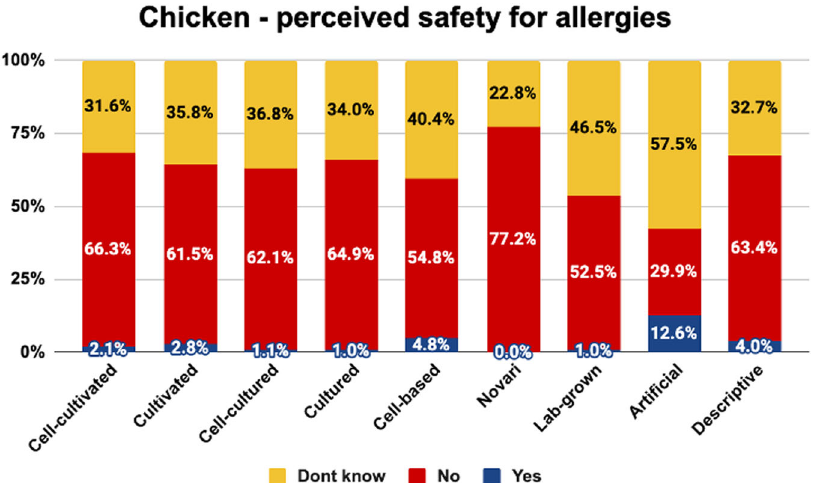
Fig. 8 Perceived allergen safety of chicken by label. The graph shows the proportion of people who correctly identi fi ed that cell-cultivated chicken products are not safe for allergy-sufferers, incorrectly identi fi ed that they are safe for allergy sufferers, and did not